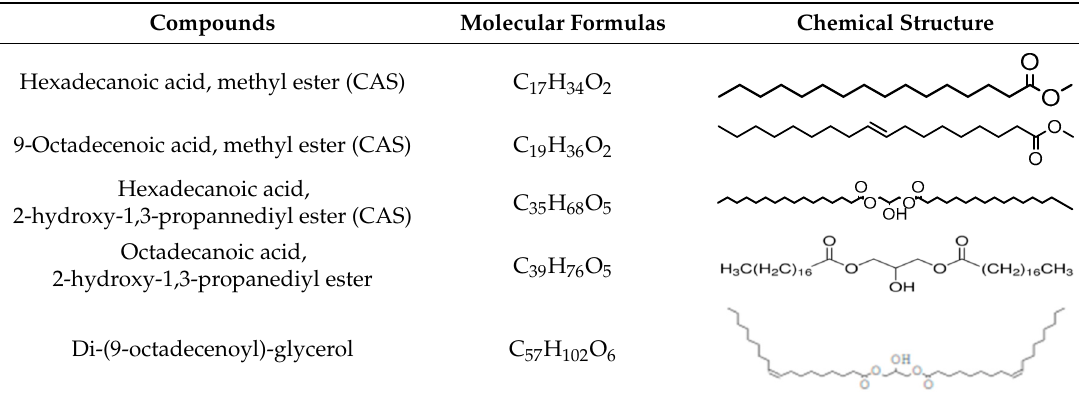
Table 5. Biodiesel components.